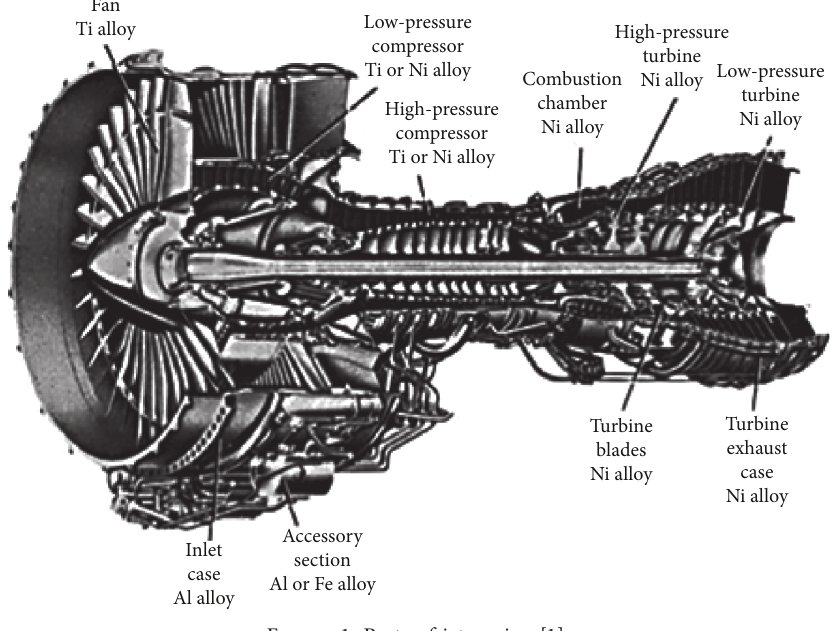
Figure 1: Parts of jet engine